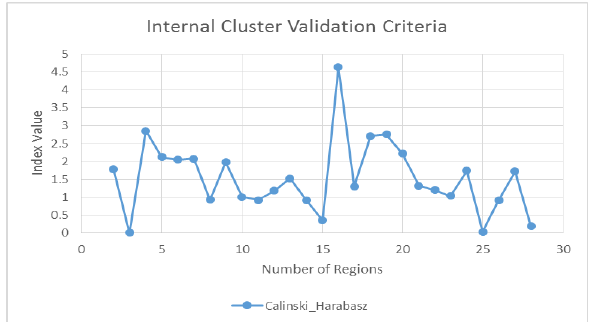
Figure 2. Calinski-Harabasz index value